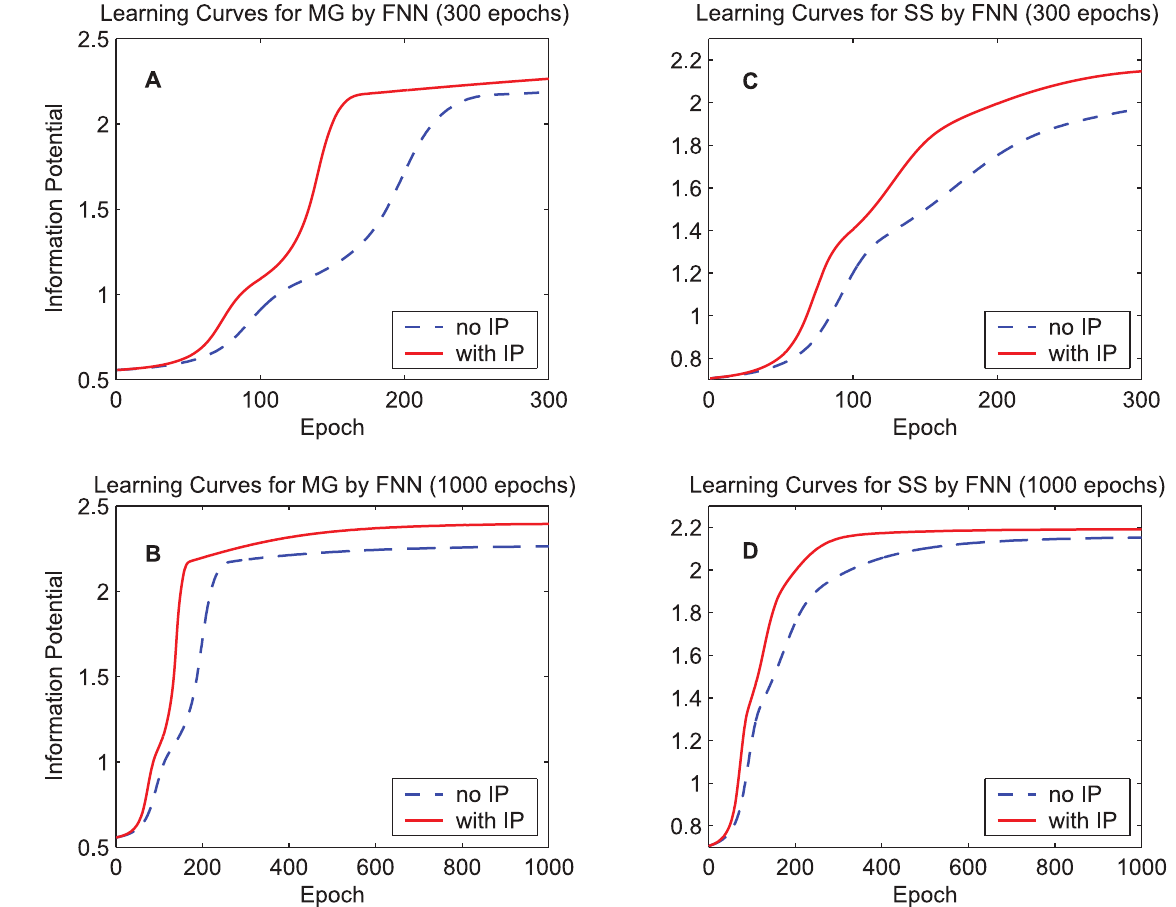
Figure 3. Learning curves of the quadratic information potential by the FNN. The dashed lines denote the learning curves of the MEE algorithm, and the solid lines denote the learning curves of the synergistic algorithm. (A) 300-epoch learning curves for the training data set ‘‘MG’’. (B) 1000-epoch learning curves of ‘‘MG’’. (C) 300-epoch learning curves for the training data set ‘‘SS’’. (D) 1000-epoch learning curves of ‘‘SS’’.